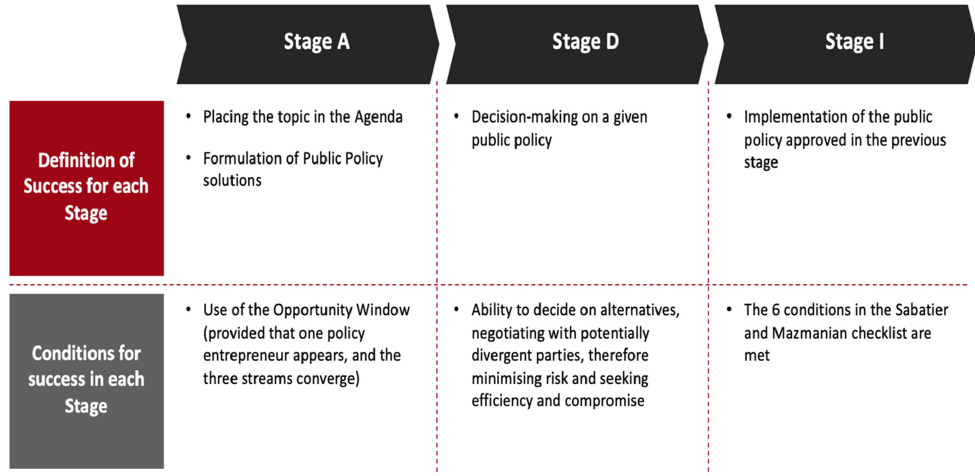
Figure 5. Definition of Success and Conditions for it to Happen in Each Stage. Source: the authors .